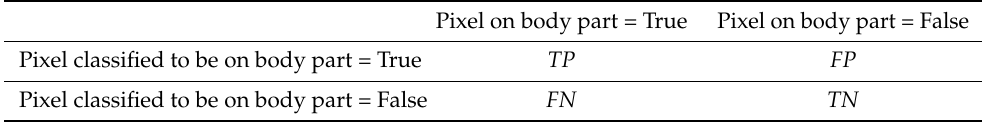
Table 2. Confusion matrix used to evaluate the classification of pixels. Pixel on body part = True Pixel on body part = False Pixel classified to be on body part = True TP FP Pixel classified to be on body part = False FN